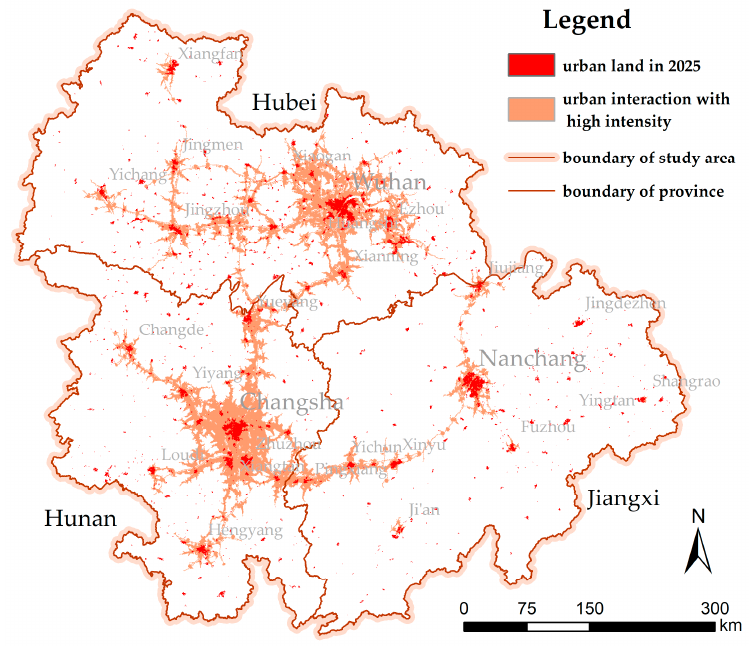
Figure 7. Distribution of urban land in 2025 and the urban interaction influence in 2015.